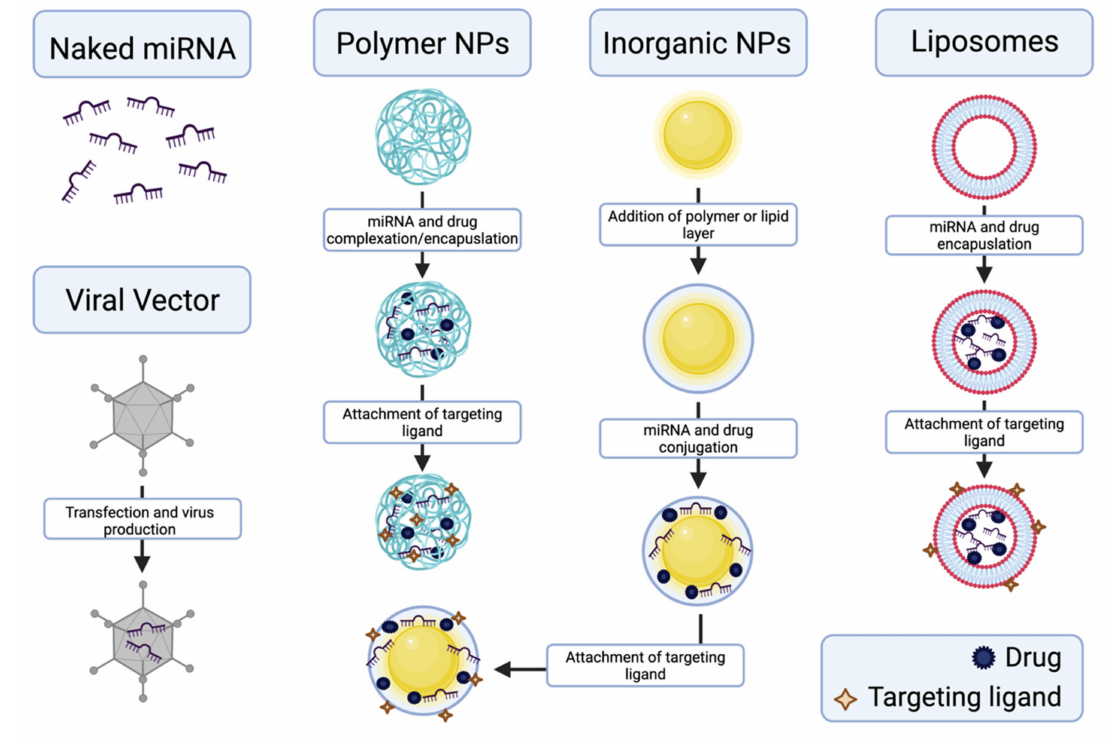
Figure 2. Schematic overview of the production of nanodelivery vehicles, including viral vectors, polymeric nanoparticles, inorganic nanoparticles, and liposomes, for miRNA and drug delivery. Created with